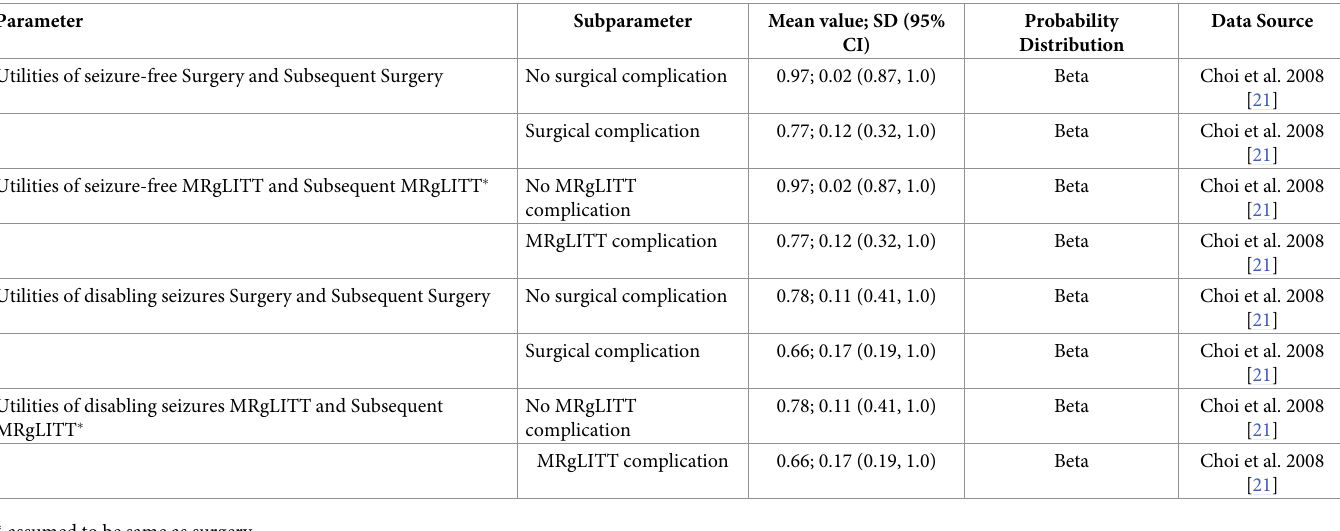
Table 3. Utility parameters for